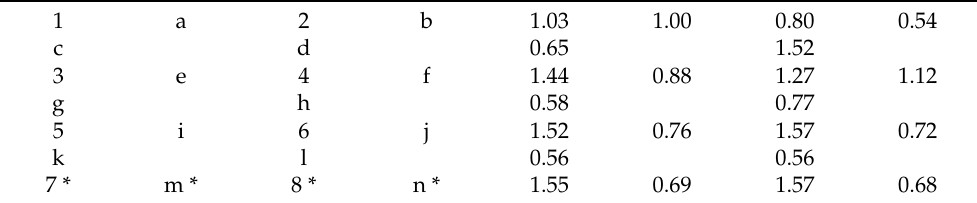
higher than those within the interface.